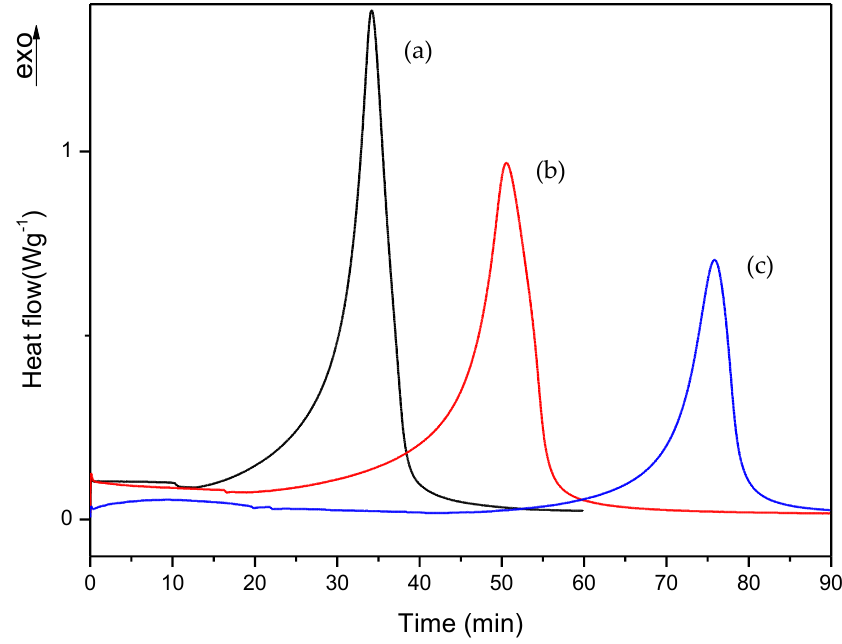
Figure 9. Isothermal DSC curves of (a) G, (b) H and (c) I formulations with 0.50% DMT.